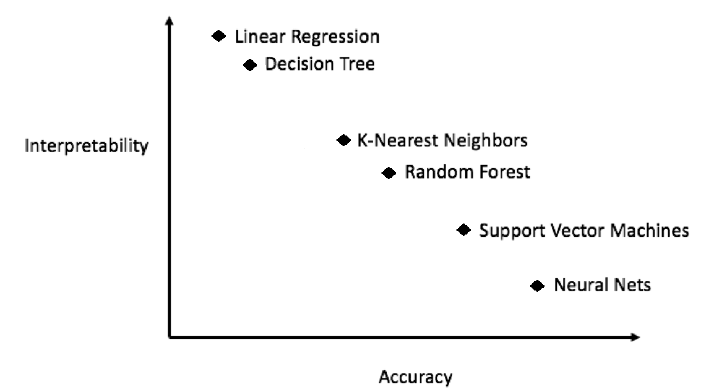
Figure 2. In general, more accurate models are less explainable.